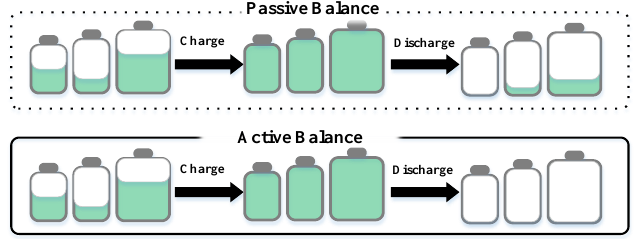
Figure 1. Passive balancing vs. active balancing methods.